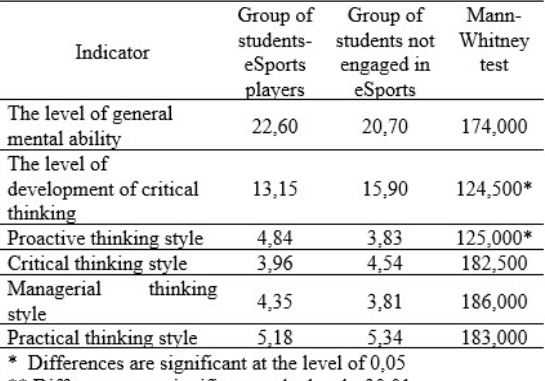
Table 3. Results of the diagnostic of the stylistic peculiarities of thinking of students- eSports players and students not involved in eSports